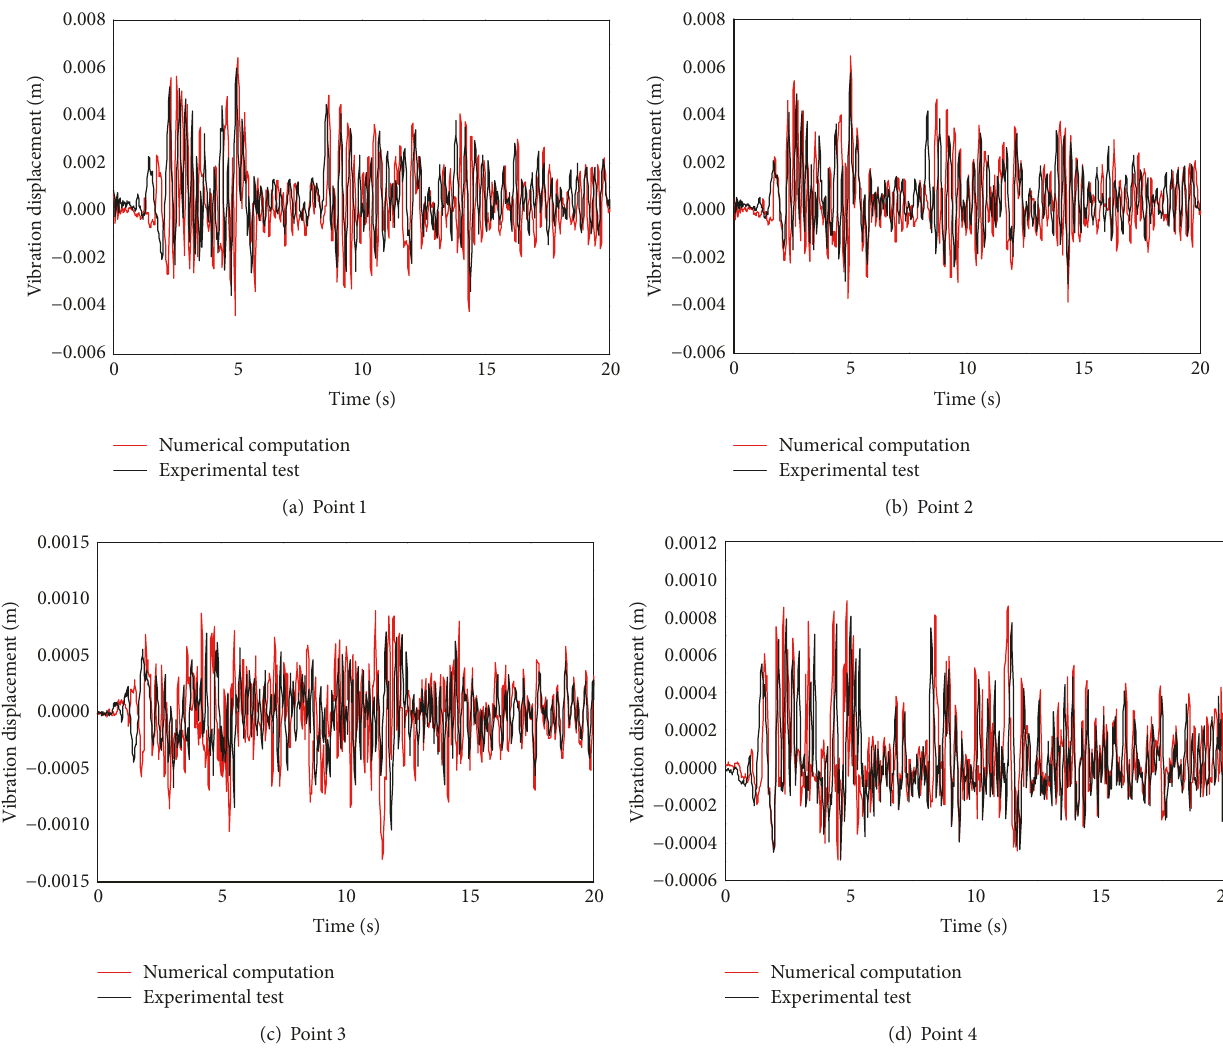
Figure 11: Dynamic responses of tested points on the masonry structure in